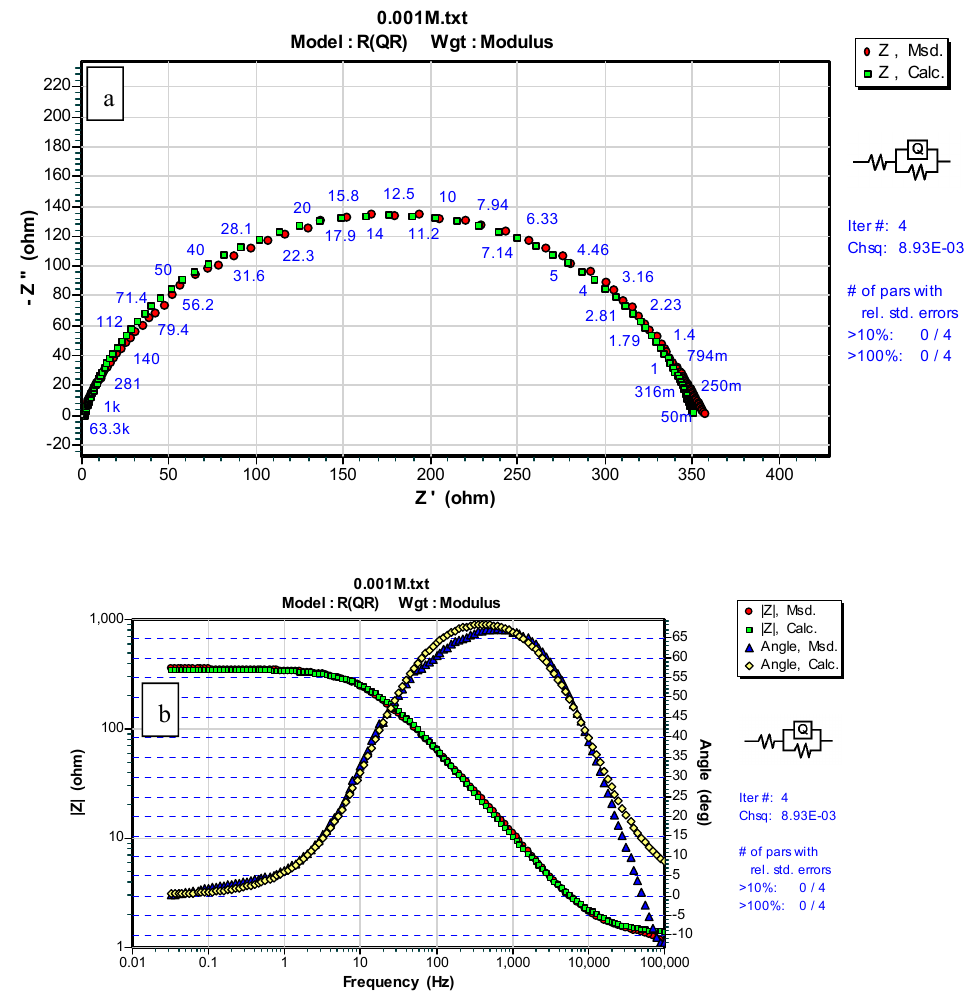
Figure 15. Simulation of EIS ( a ) and Bode ( b ) plots for MS in 1 M HCl in the presence of 0.001 M of CGSES14 at 20 ◦ C. Table 5. Electrochemical impedance parameters for CS in 1 M HCl with and without di ff erent concentrations of the synthesized cationic gemini surfactants at 20 ◦